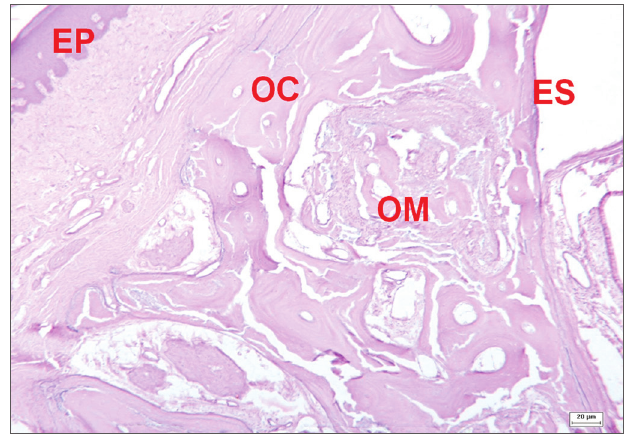
Figure 8. Histological section of an experimental surgical defect with no bone discontinuity, showing bone regeneration sites